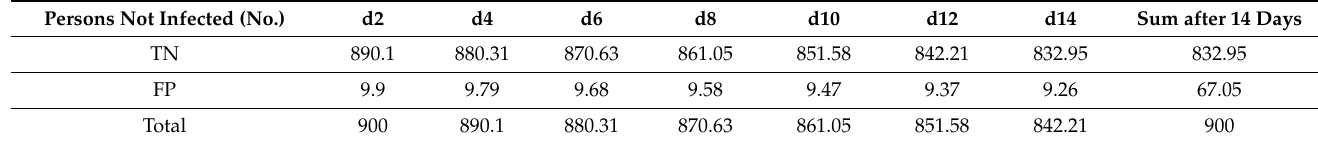
Table A2. Number and distribution of HCW who remain uninfected during